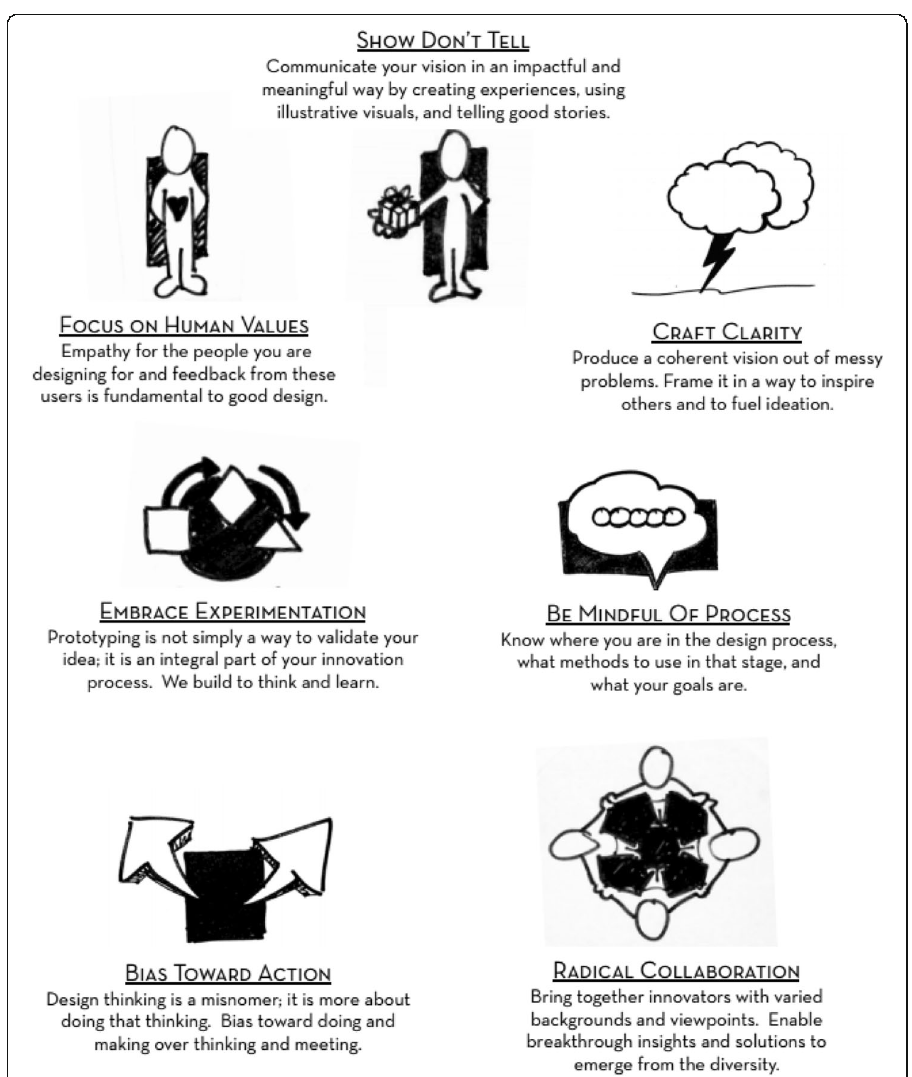
Fig. 1 d.Mindsets as presented by the Stanford d.school (d.school, 2011, p.